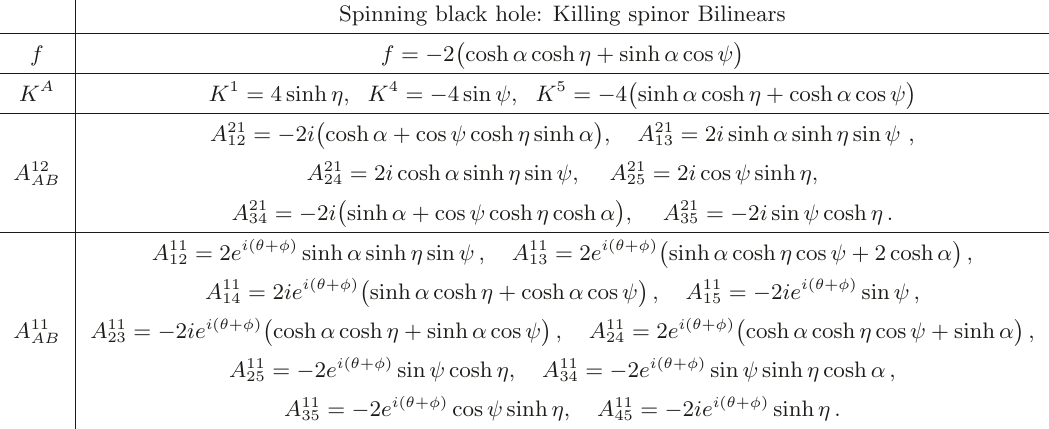
of AdS 2 S 2 ⋉ S 1 . ++ ×